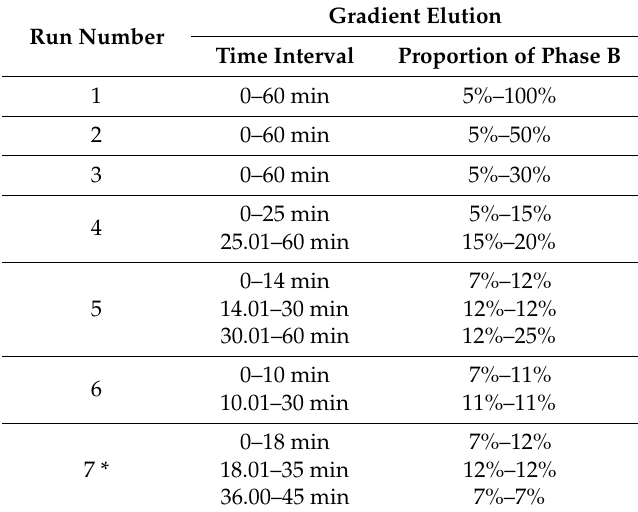
Table 1. Gradient elution tested in development of the HPLC chromatographic method for analysis of EtOAc phase of A. occidentale